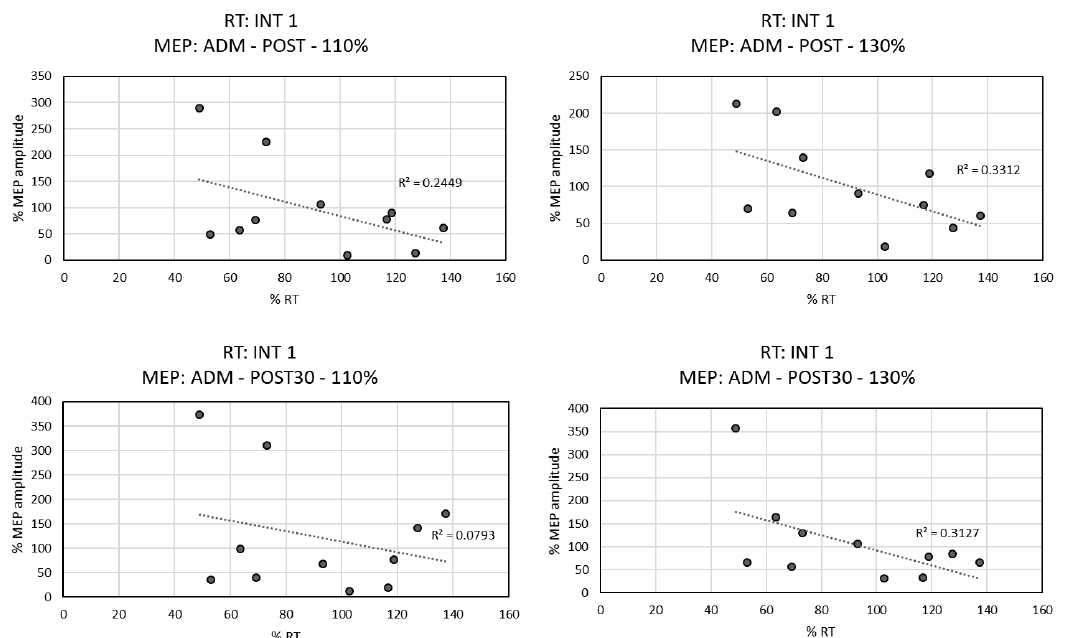
Figure 6. Sham group correlation between % of MEP amplitude and % of RT based on Pre-Assessment time. Simple linear regression and the coefficient of determination of the correlation of behavior RT performance in the first intervention with MEP amplitudes of ADM in Post- and Post-30’-Assessment at 110% and 130% of RMT. No correlation was found between the RT of the Int1 and the APB MEPs. No other correlations between RT and MEP amplitude were found.